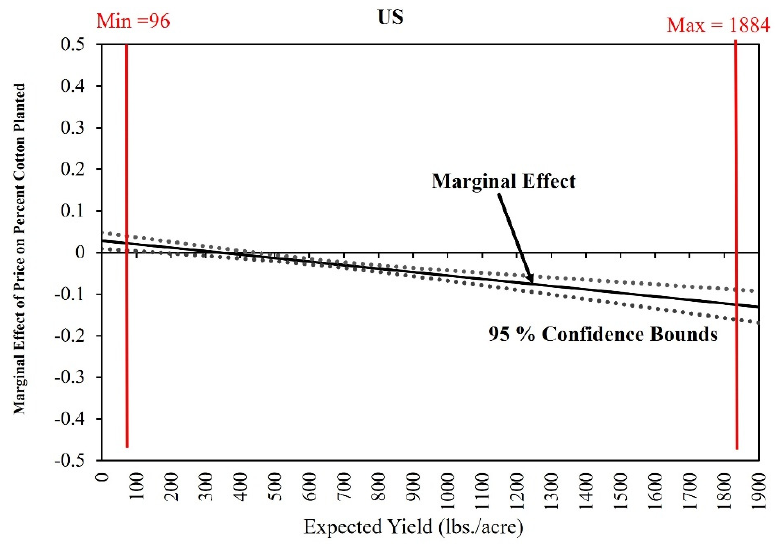
Figure 6. US marginal effect of expected price on the percentage of cotton planted given expected yield.